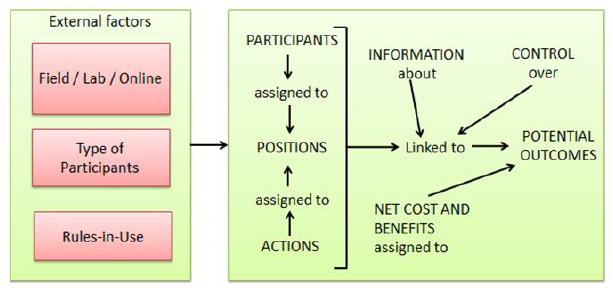
Fig. 1 . Experimental models of social-ecological systems